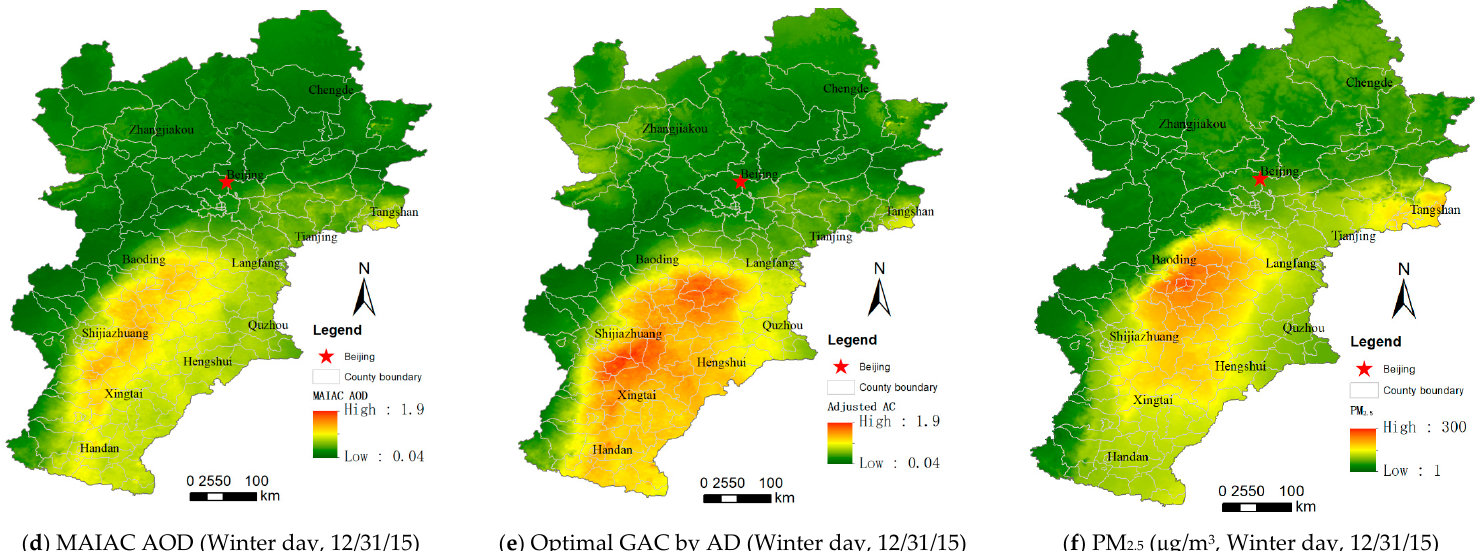
Figure 8. Grid surfaces of Multiangle Implementation of Atmospheric Correction (MAIAC) AOD ( a , d ), optimal ground aerosol coefficient by AD ( b , e ), and PM 2.5 predicted using optimal GAC ( c , f ).